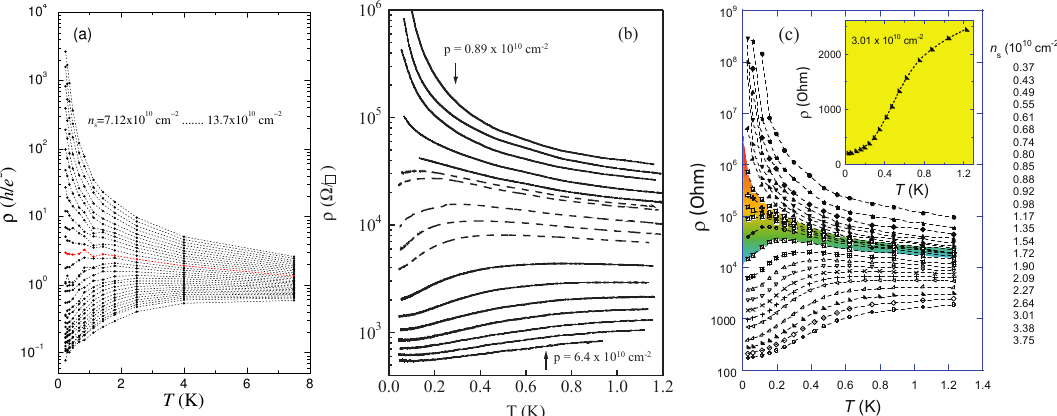
Figure 1. Resistivity as a function of temperature in a Si MOSFET ( a ), p -type GaAs/AlGaAs heterostructure ( b ), and SiGe/Si/SiGe quantum well ( c ). Figures adapted from [15], [16], and [8],